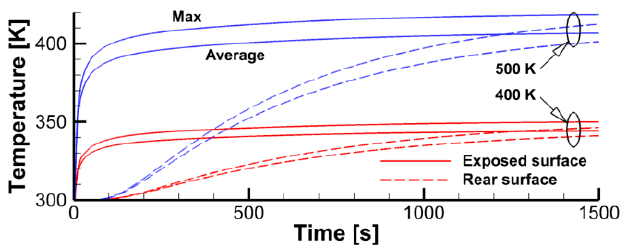
Figure 18. Transient variation of peak and surface-average temperatures for the sample impacted by thermal radiation from the heater. The heater temperature is indicated.